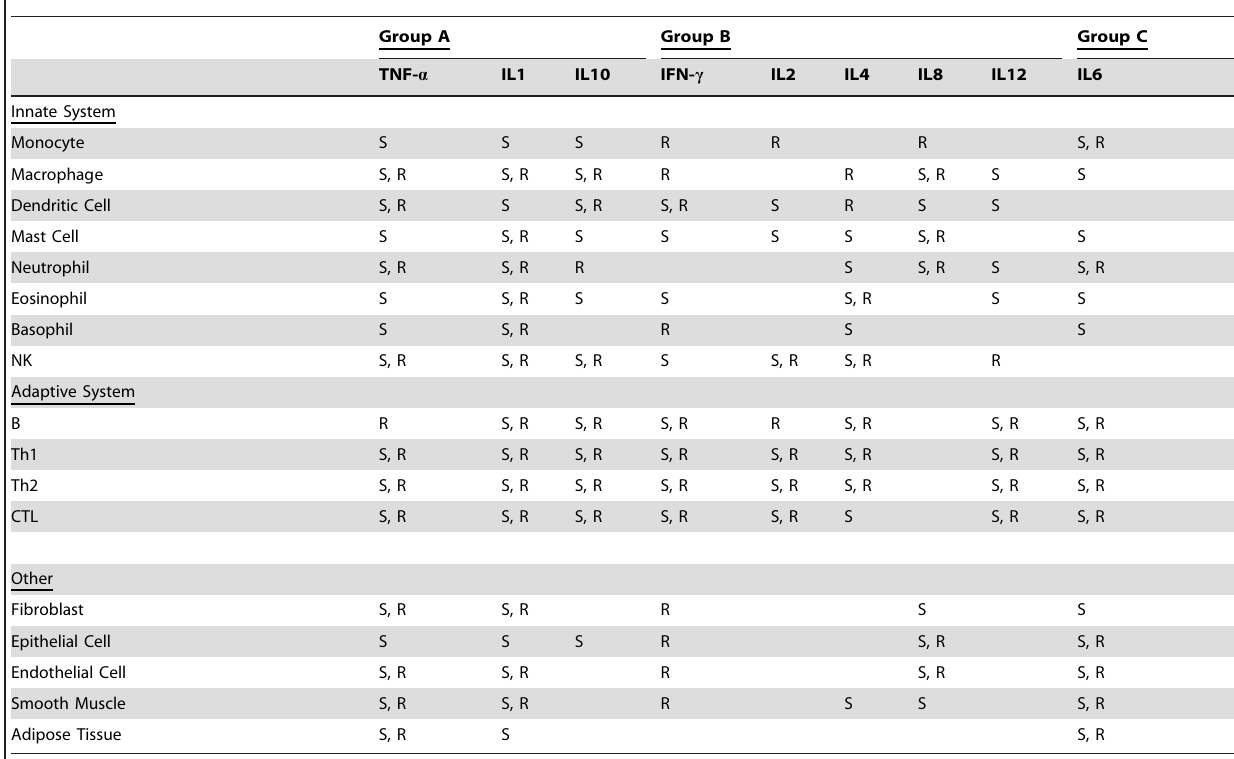
Table 4. Cells That Secrete and are Regulated by the Measured